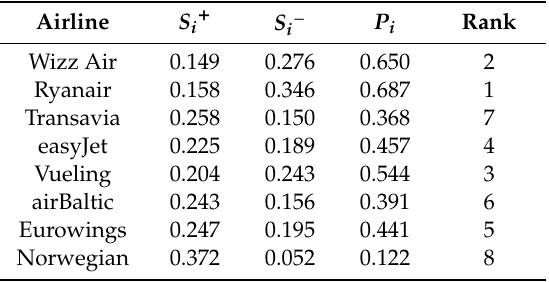
Table 5. Results successfulness TOPSIS. Compiled by the